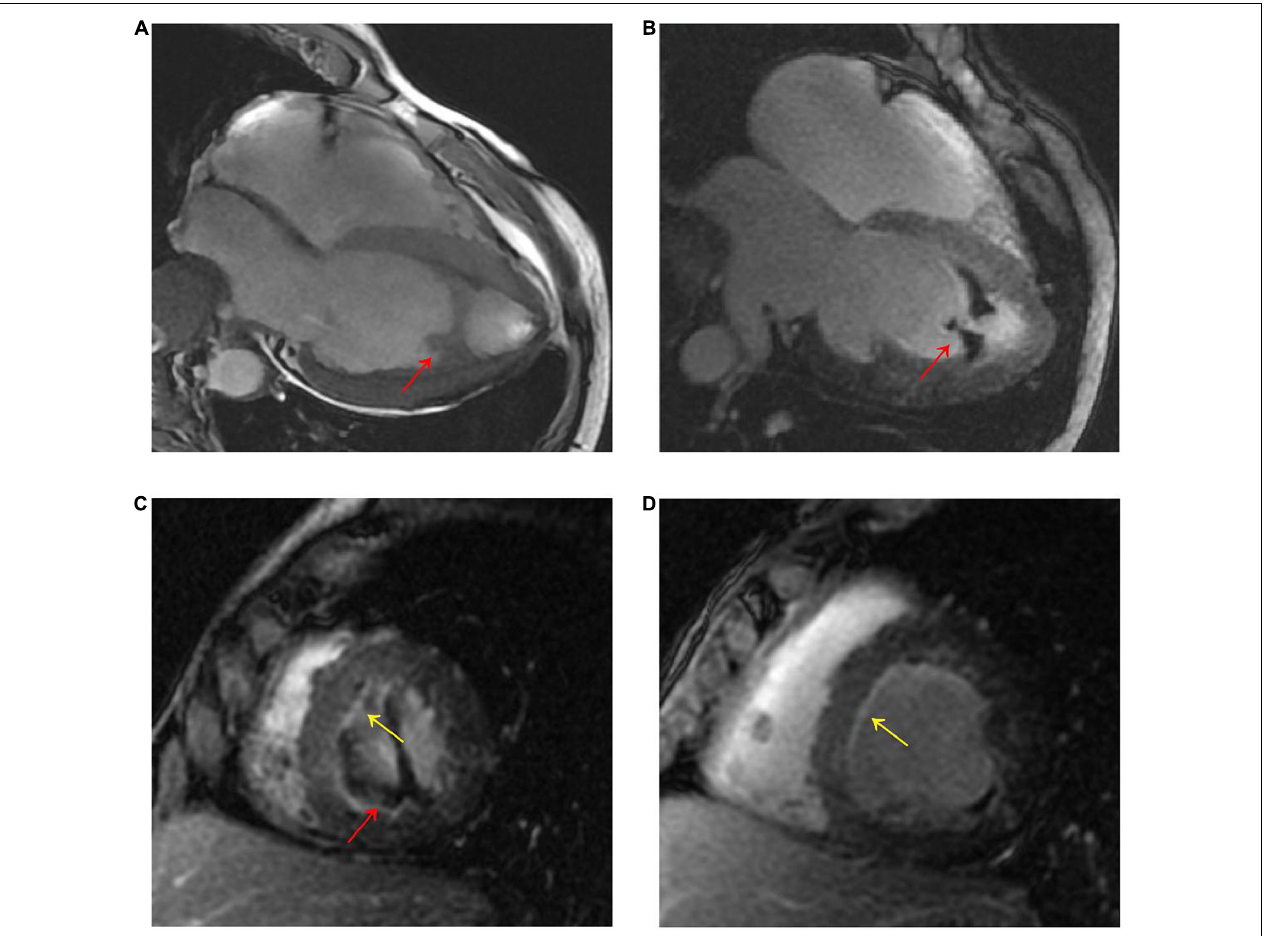
FIGURE 3 | (A) CMR four-chamber cine sequence exhibited arc-like region in the LV apex (red arrow). (B–D) , Late gadolinium enhancement imaging showed LV apex arc-like unenhanced region (red arrow), and diffuse subendocardial enhancement in LV mid- to apical parts (yellow arrow). The patient was diagnosed with Loeffler’s endocarditis based on the typical clinical and imaging